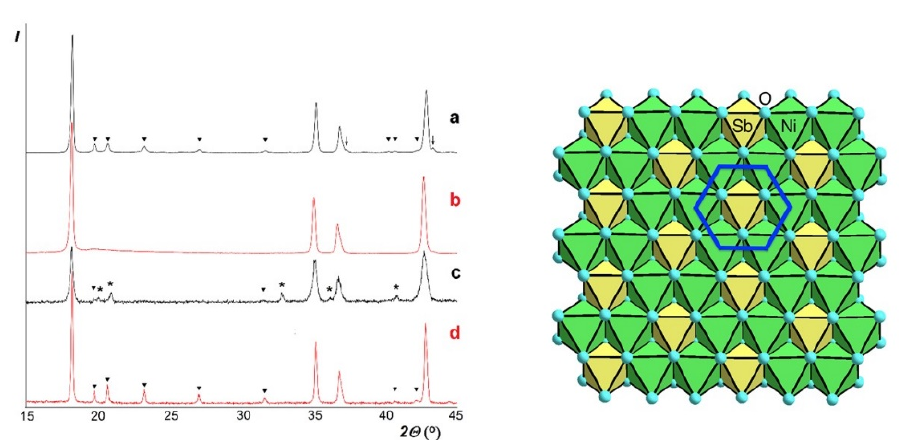
Figure 1. ( Left ) Comparison of low-angle parts of XRD patterns where most intensive foreign and superlattice reflections are observed. (a) Li 3 Ni 2 SbO 6 [26]; (b) Li 0.8 Ni 0.6 Sb 0.4 O 2 or “Li 2.4 Ni 1.8 Sb 1.2 O 6 ”; (c) Same after 0.5 h at 1270 K; (d) Li 2.6 Ni 2.2 SbO 6 . Filled triangles ( (cid:72) ), superlattice reflections due to Ni/Sb ordering; asterisks (*), reflections from LiSbO 3 ; arrows ( ↓ ), reflections from NiO (only found in a). ( Right ) Top view on the magnetic plane of Li 3 Ni 2 SbO 6 . The little light-blue circles are oxygen. Nickel ions are in the center of the green oxygen octahedra, antimony ions are in the yellow ones. The dark blue line marks the honeycomb motif in the magnetic structure of the plane.